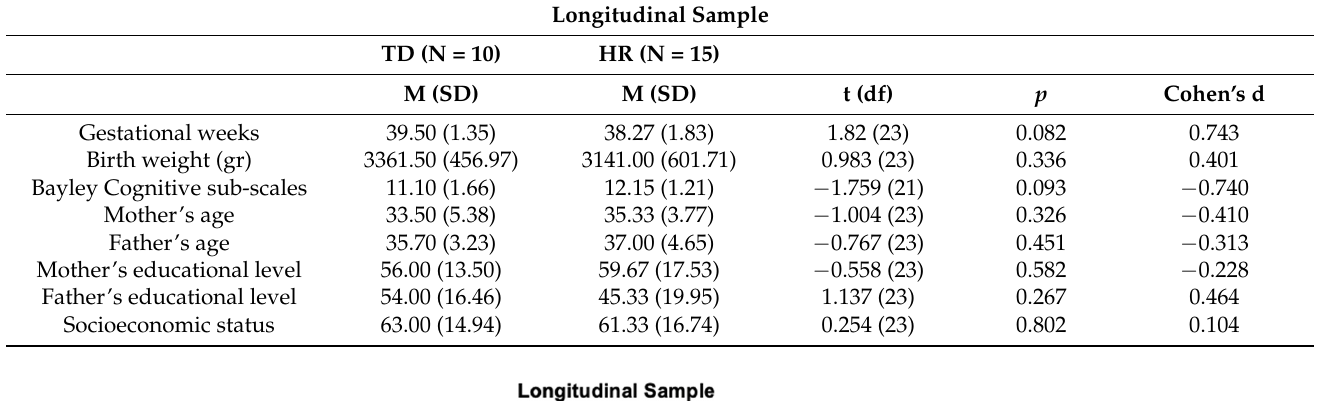
group (HR vs. TD) x task (SL vs. RL) ANOVA, which revealed the presence of a significant